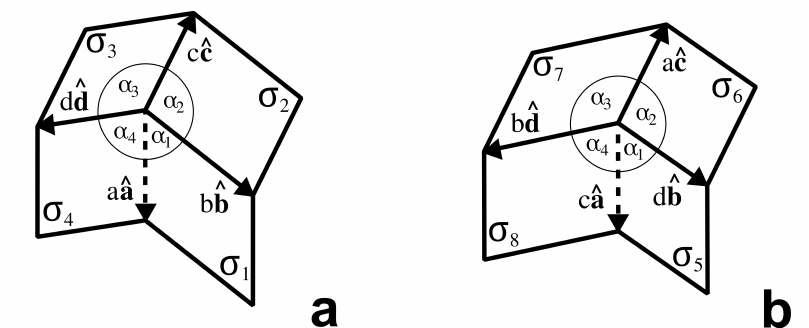
Figure 1. ( a ) Vectors defining the basic asymmetric degree-four vertex cell, C 1 . ( b ) Vectors defining the complementary degree-four vertex cell, C 2 . (Adapted from